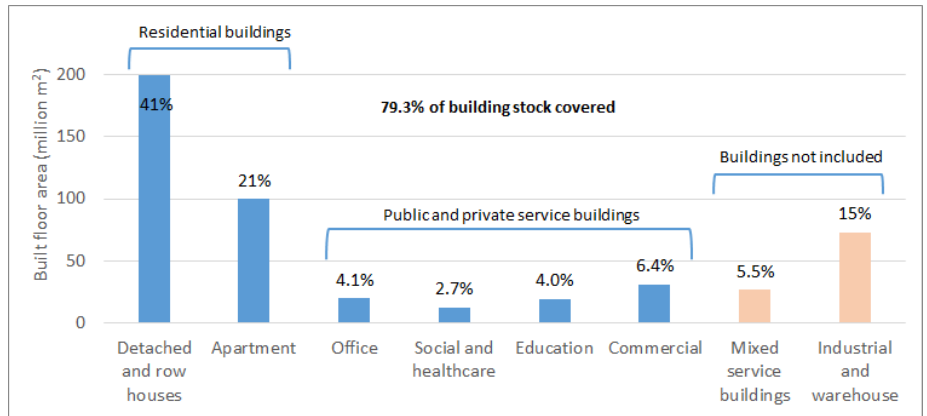
Figure 1. The amount of different building types in the Finnish building stock.